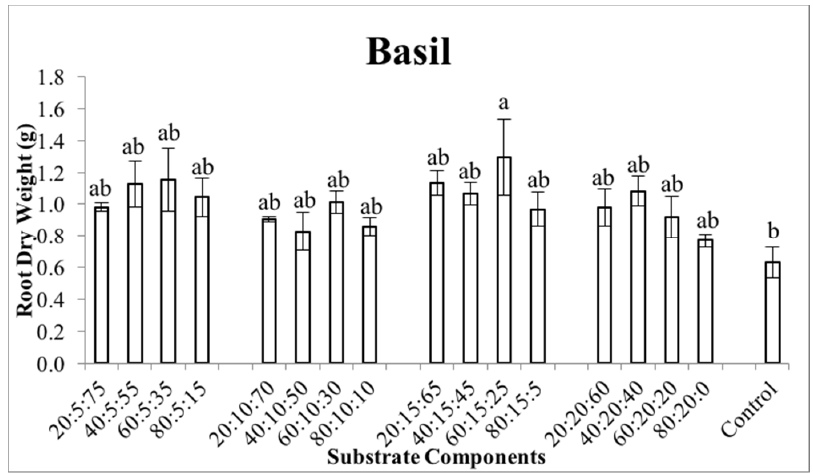
Figure 4. Root dry weight (mean ± standard error) per basil plant harvested at 9 weeks after transplanting. The ratios on the X -axis indicate the percentage ratio of biochar to vermicompost to commercial substrate (by volume). The control was 100% commercial substrate (Berger BM7 35BKS). Means indicated by the same letter are not significantly different according to Tukey’s HSD test at p < 0.05 ( n = 6).